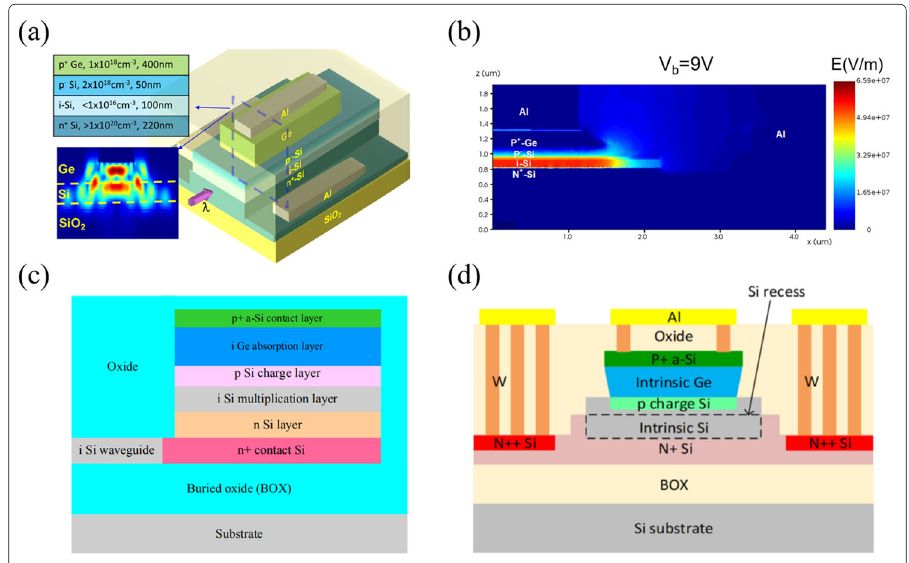
Fig. 6 a Schematic and b electric field distribution of the waveguide-coupled low-voltage Si-Ge SACM APD [94]; c Schematic cross-section of the 56 GHz waveguide-coupled Si-Ge SACM APD [95]; d Schematic cross-section of the recess-type waveguide integrated Si-Ge SACM APD